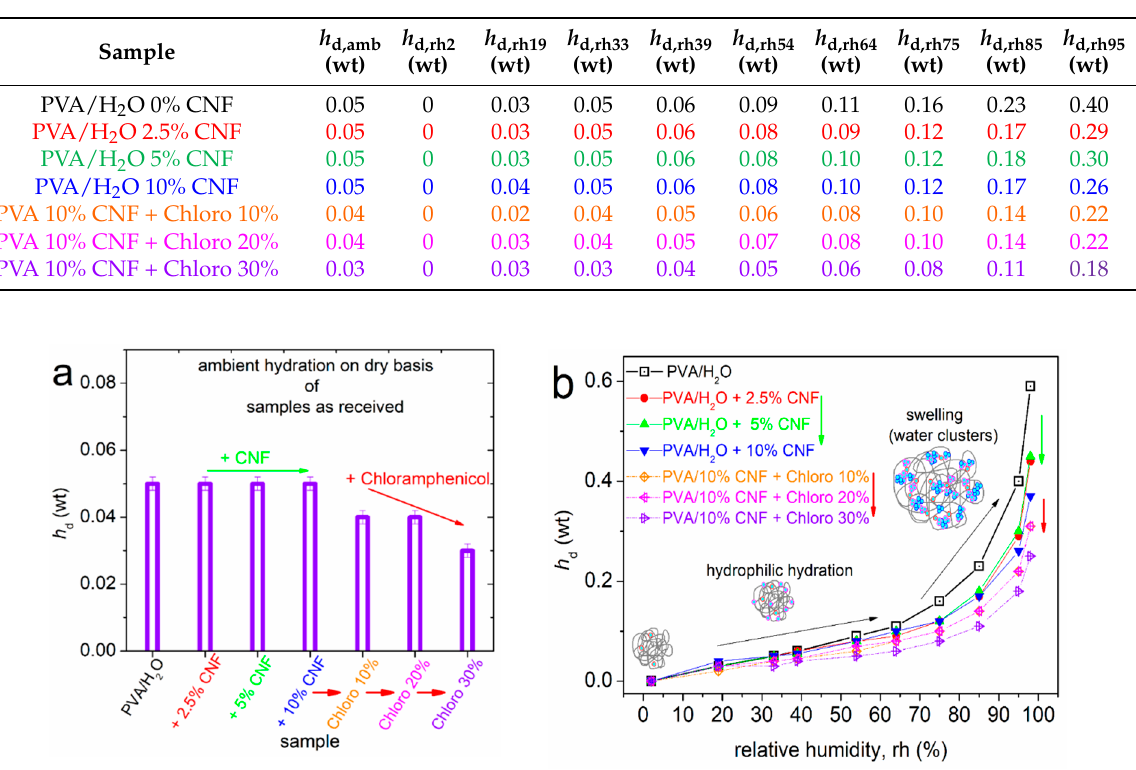
Figure 7. ( a ) The ambient hydration on dry basis for all samples investigated. The added arrows mark the effects imposed by the CNF content, moreover, by the chloramphenicol amount. ( b ) Raw data for hydration, h d , against relative humidity during the ESI measurements at RT. The inset schemes are used to visually explain the progressive hydration stages.